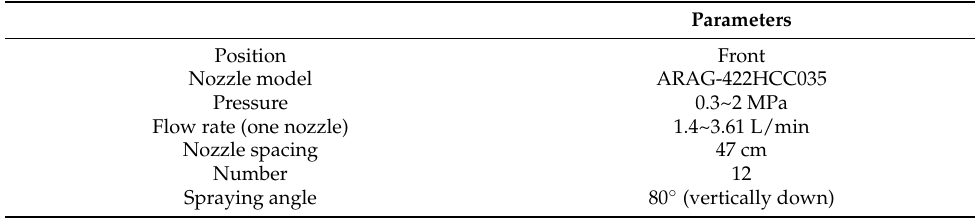
Table 1. Characteristic parameters of the nozzle.